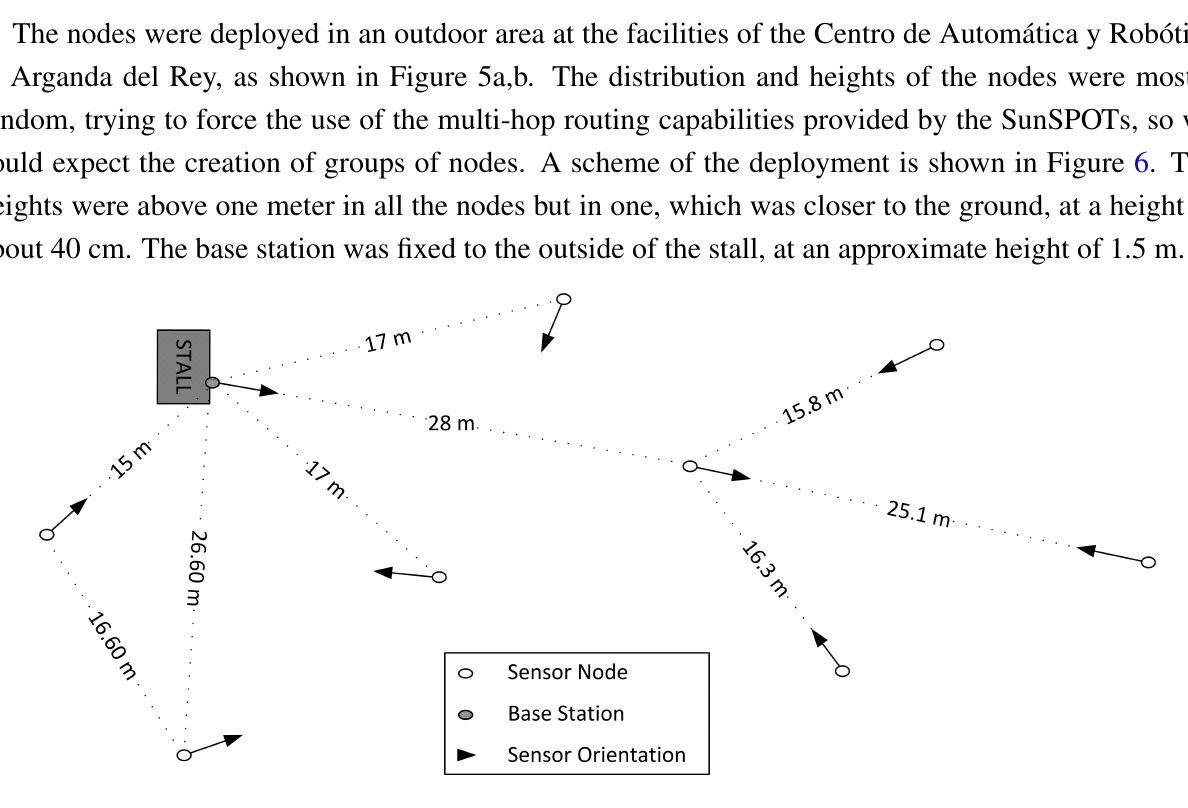
Figure 6. Experiment